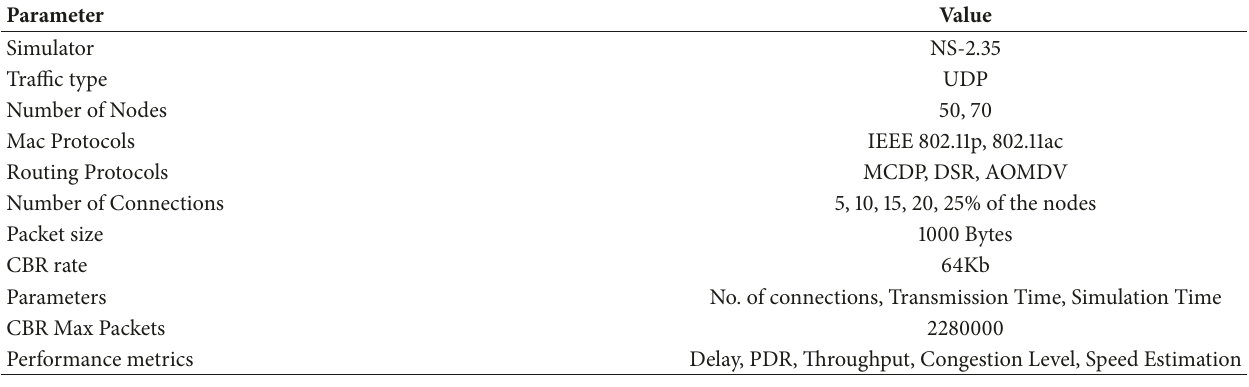
Table 5: Network simulation parameters.